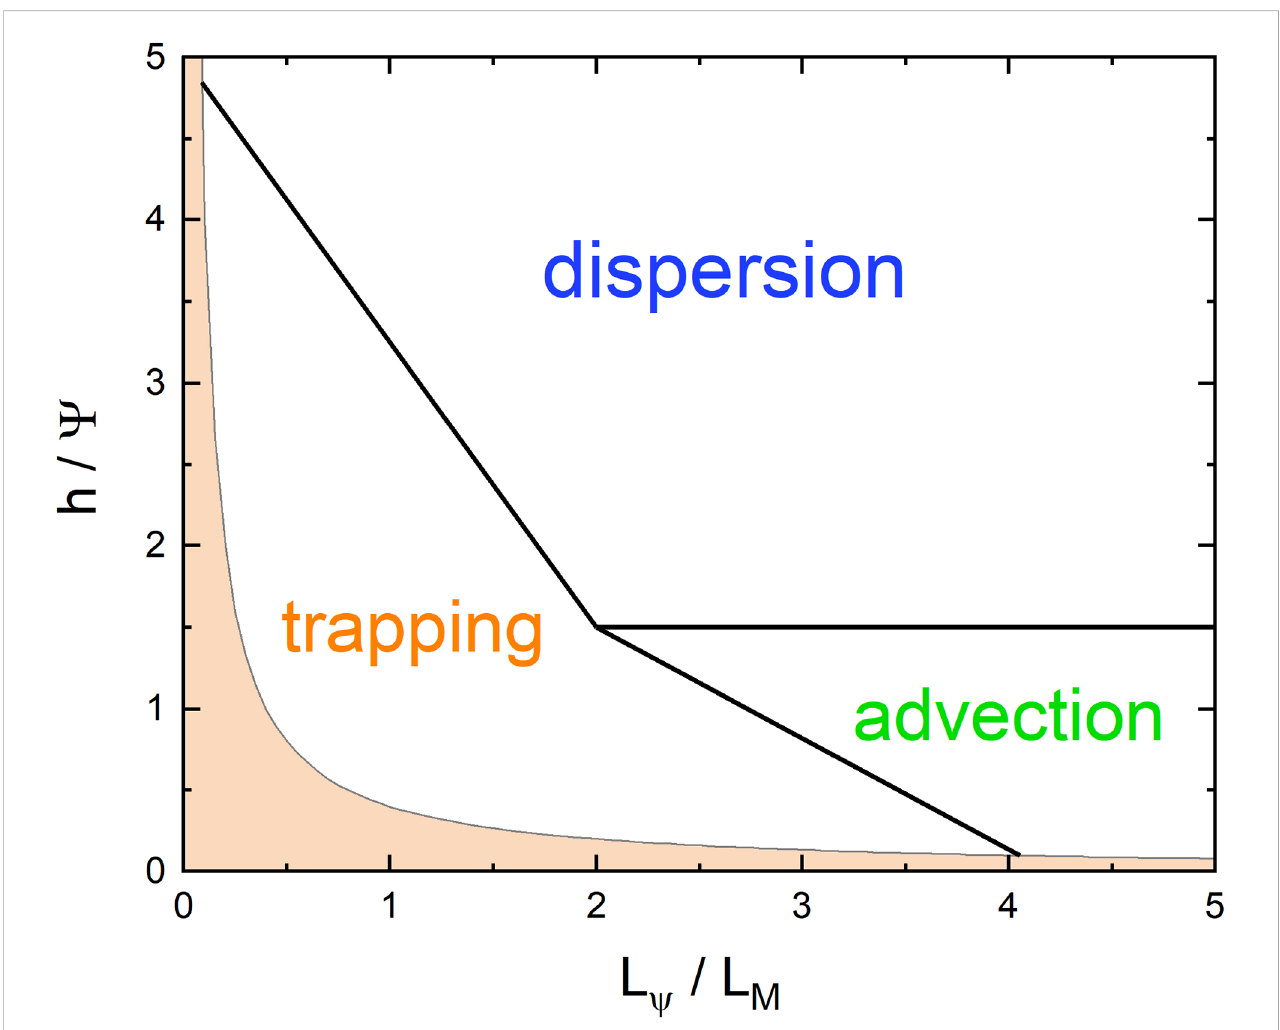
FIGURE 13 Schematic diagram of the regime classi fi cation. The shaded part is the forbidden area of the system, which is determined by the scale of the most concentrated